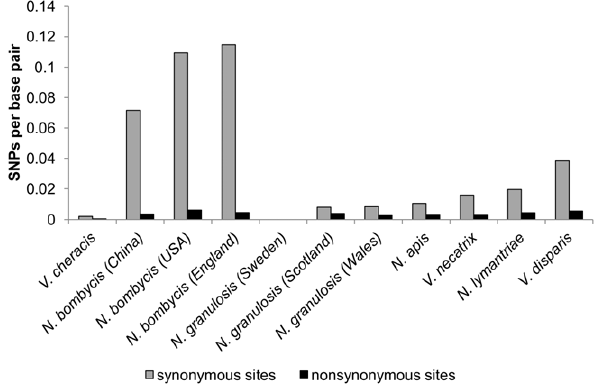
Figure 6. Numbers of synonymous and nonsynonymous single nucleotide polymorphisms (SNPs) detected by direct sequenc- ing of the RPB1 gene from Nosema isolates.